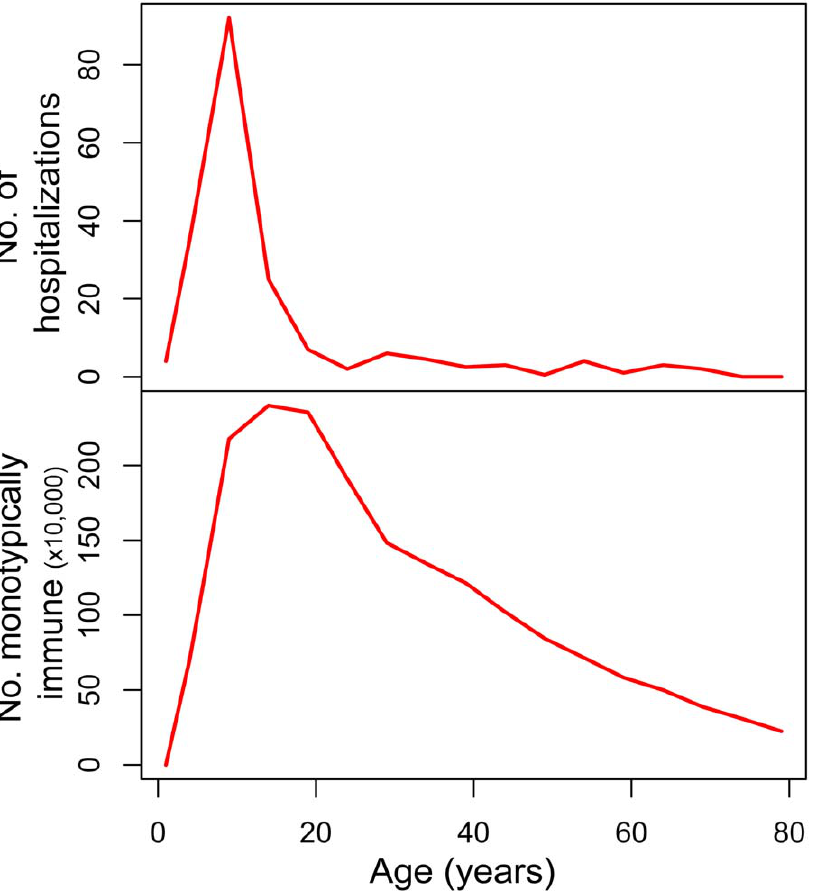
Figure 4. Age distribution of hospitalized dengue cases in Brazil, 2007 resembles expected age distribution of monotypically immune. Age distribution of hospitalized dengue cases in Pernambuco, 2007 [20] (top). Age distribution of monotypically immune, 20 years after the introduction of dengue virus into a previously susceptible population, as predicted by the model (bottom). l (DENV 1, 2 and 3) =0.05.